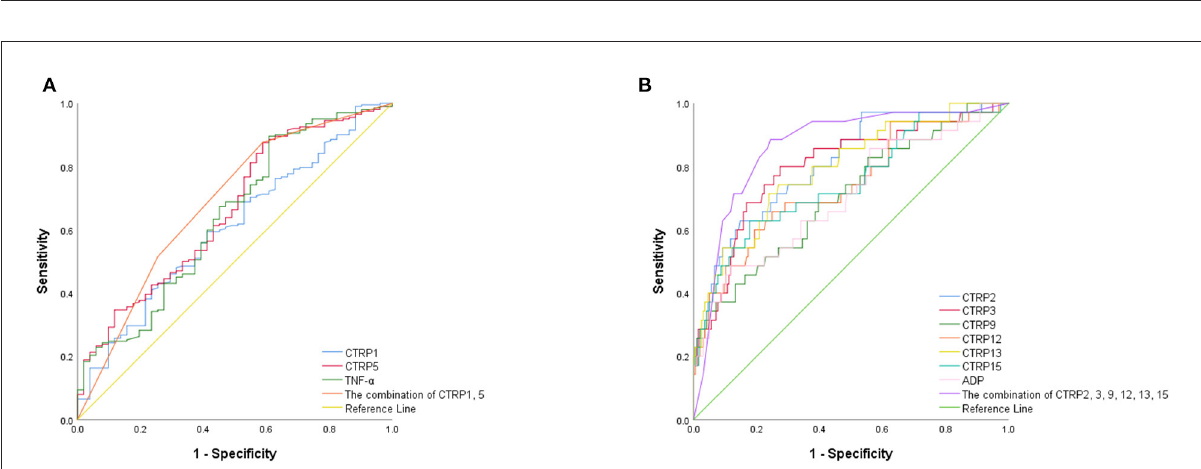
FIGURE2 ROC curves of (A) pro-inflammatory and (B) anti-inflammatory adipocytokines for predicting